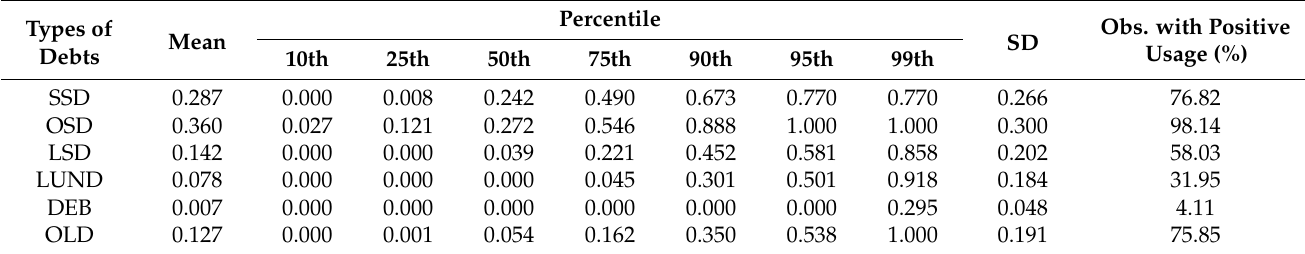
Figure 1. Debt types and debt specialization over time. Table 2. Descriptive statistics for debt